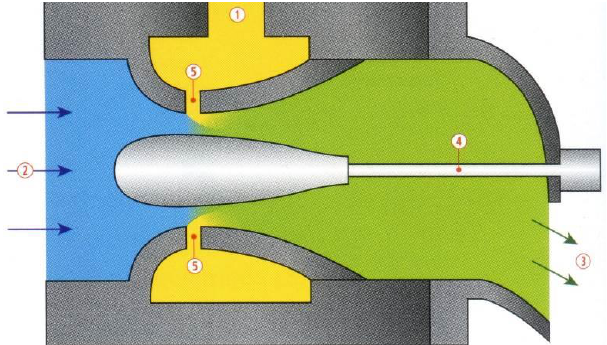
Fig. 19. A cross-sectional view of a gas mixer with an adjustable venturi insert, where 1 is the gaseous fuel supply, 2 is the air supply, 3 is the air-fuel mixture to the intake manifold of the gas- or dual-fuel engine, 4 is the adjust- able venturi insert shaft connected to stepper motor, and 5 are bores for the